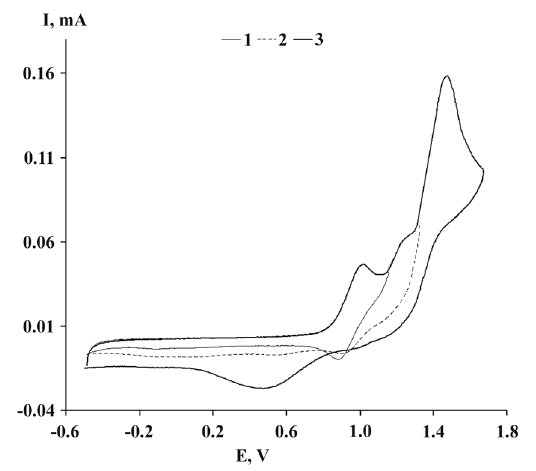
Figure 7. Cyclic voltammograms of compound 2 (in the potential switch from − 0.50 to 1.15 V—curve 1; in the potential switch from − 0.50 to 1.30 V—curve 2; in the potential switch from − 0.50 to 1.70 V— curve 3) (CH 2 Cl 2 , C = 3 mM, 0.15 M TBAP, scan rate 200 mV·s − 1 ).